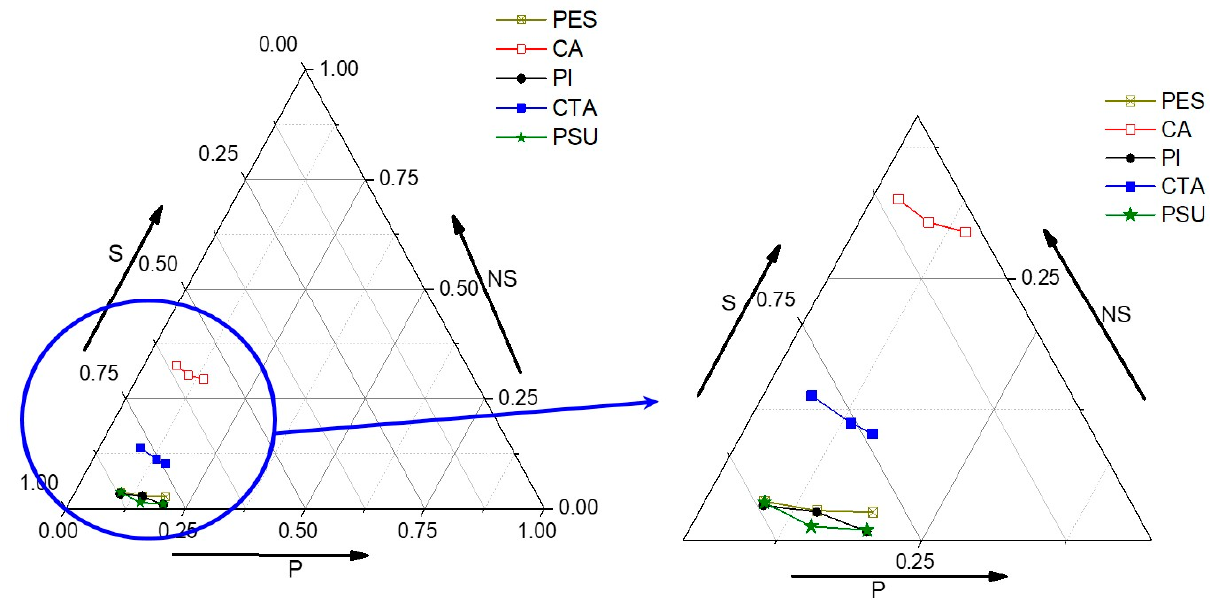
Figure 2. Phase diagrams of the polymer-GVL-water ternary systems obtained by the titration method to determine the cloud point (right figure = enlarged zoom).